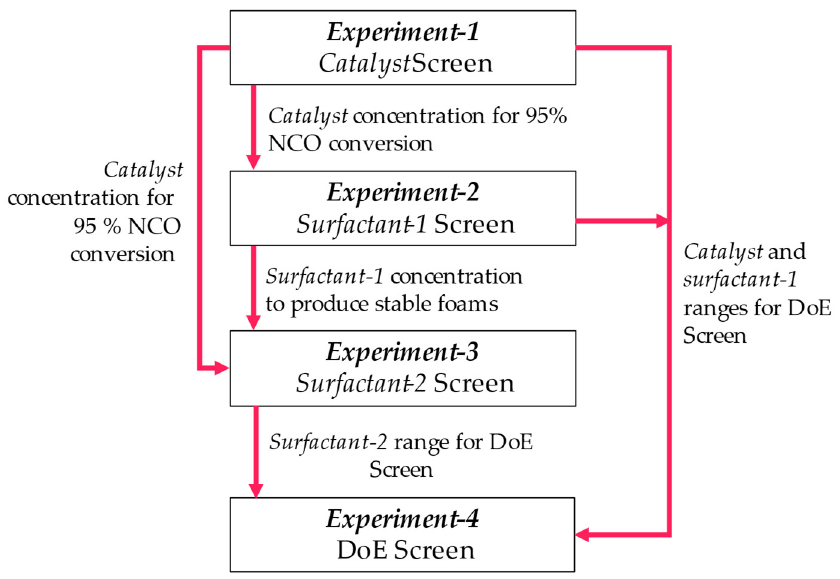
Figure 2. The flow of the four iterative experiments completed to understand the experimental space for a polyurethane foam formulation. for a polyurethane foam